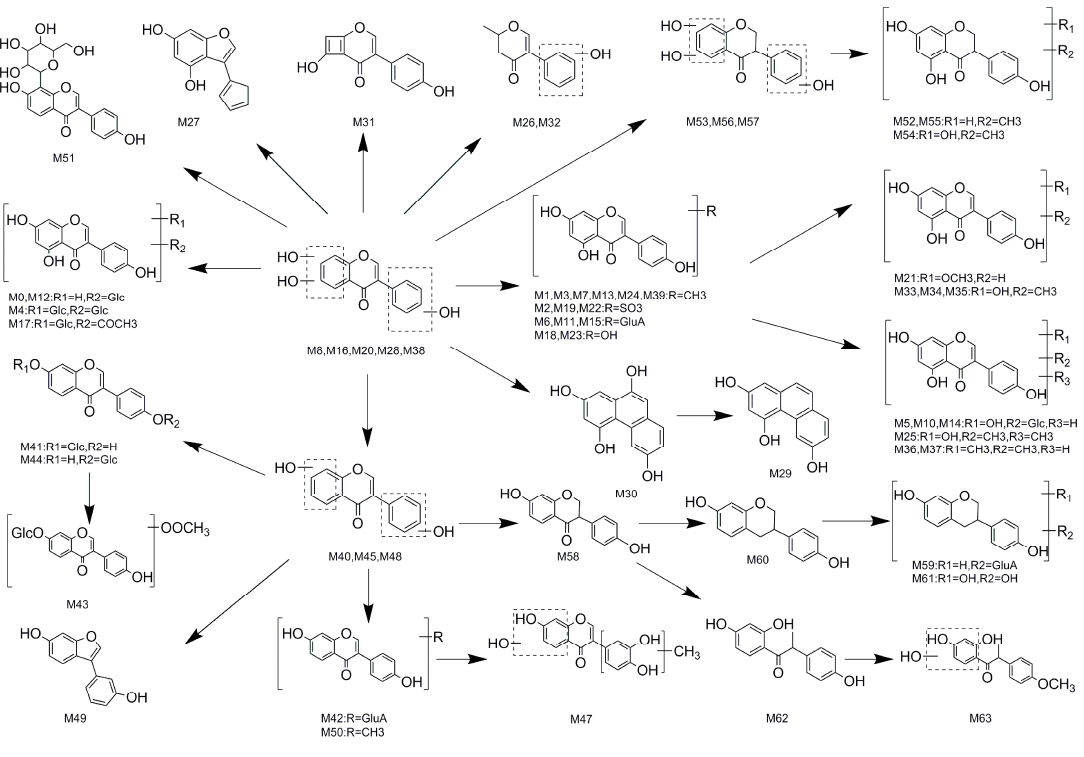
Figure 7. The proposed genistin metabolic patterns in vivo .